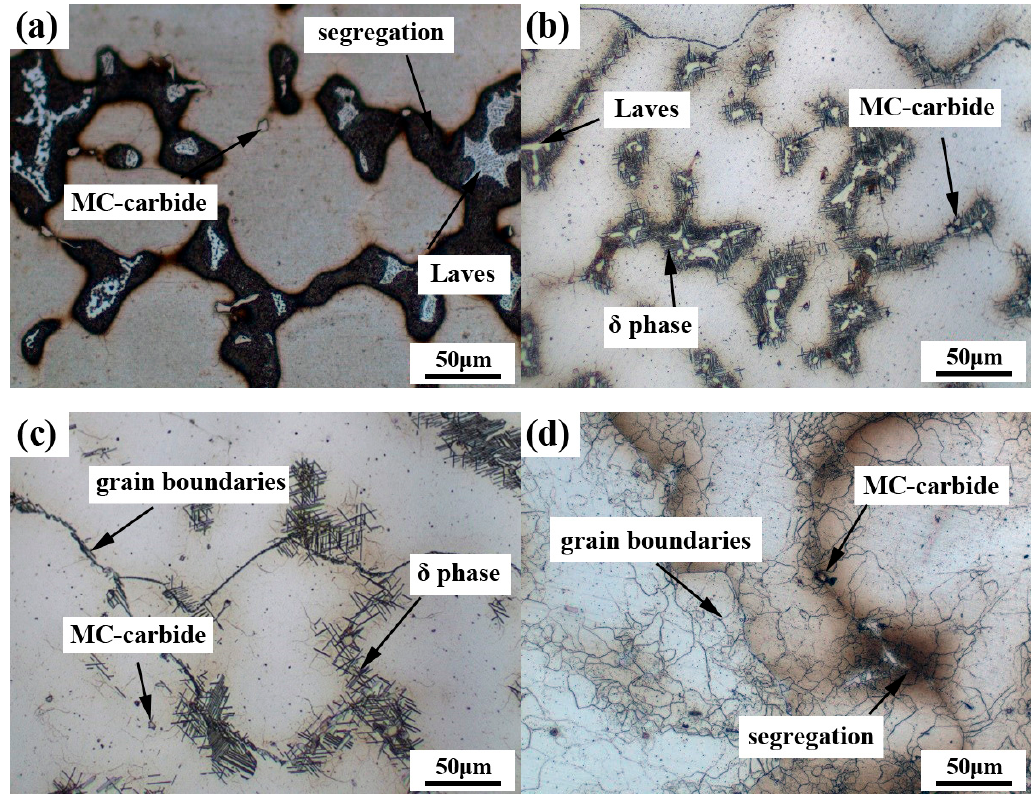
Figure 2. The optical microstructures of the Inconel 718 superalloy after different heat treatments: ( a ) the cast case; ( b ) standard heat treatment (SHT); ( c ) hot isostatic pressing + solution treatment + aging (HIP + STA); ( d ) HIP + direct aging (DA).